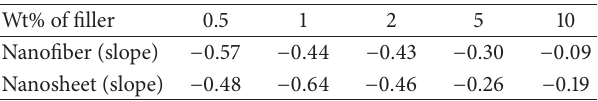
Table 2: Slope results of logarithm tan 𝛿 plot with varying nanofiller loading. Slope of neat PS is −